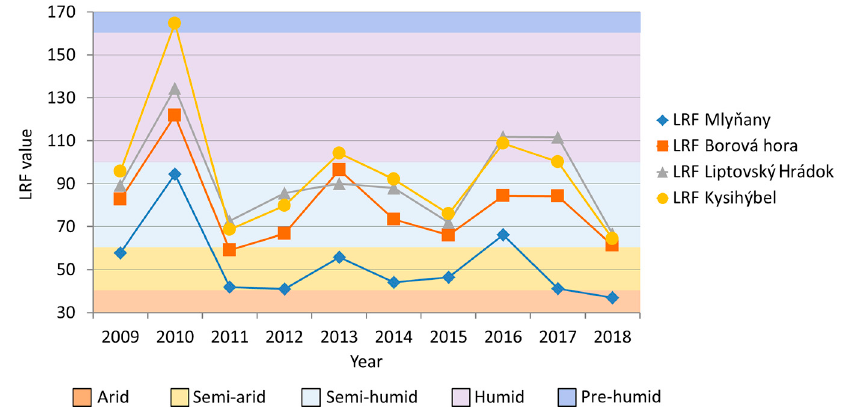
Figure 2. Lang’s rain factor (LRF) for the years 2009 to 2018. The LRF was calculated as the ratio of the mean annual precipitation (in mm) and the mean annual air temperature (in °C) [26].